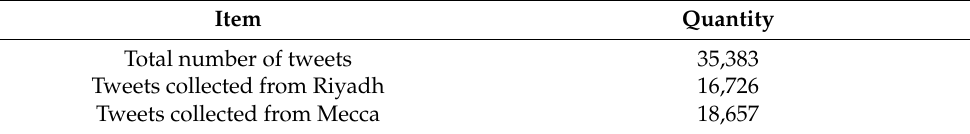
Table 4. Statistics on the data after